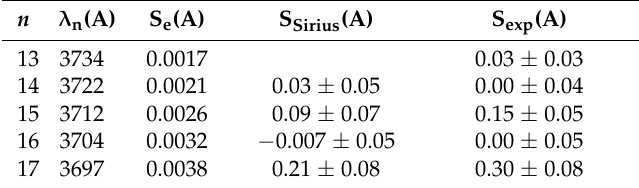
Table 2. Electronic shift S e of the hydrogen spectral lines H 13 –H 17 , as calculated by formulas from papers by Griem [41,43] and their comparison with the shifts from paper by Bengtson and Chester [34] observed in astrophysical (S Sirius ) and laboratory (S exp ) plasmas. All of the shifts are in Angstrom. n λ n (A) S e